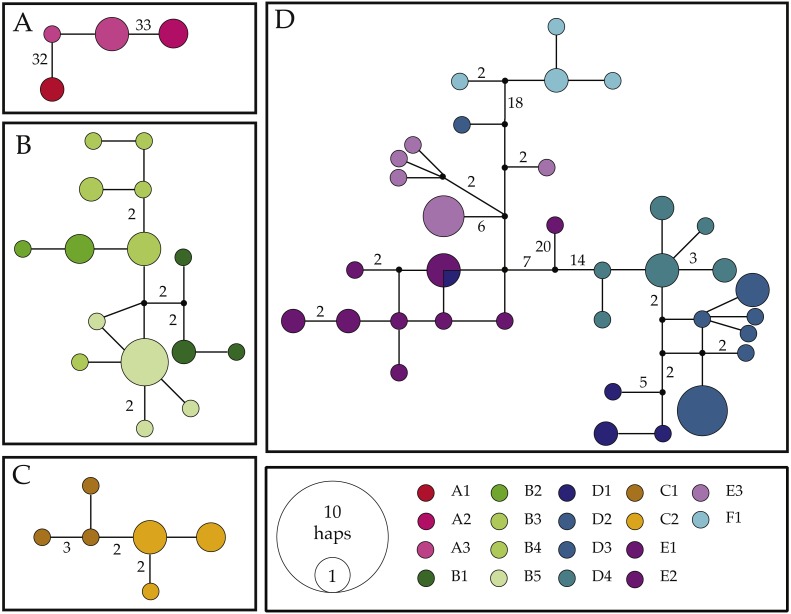
Haplotype networks for the COI mitochondrial gene fragment of Ligia from southern Africa.Colors correspond with those used in other figures. Black circles represent inferred unsampled haplotypes with numbers along branches showing number of nucleotides differences between haplotypes. Frequency of haplotype recovery is represented through the relative sizes of the circles. (A–D) represent networks which are more than 5% different. Locality labels correspond with those in Fig. 1 and Table 1.